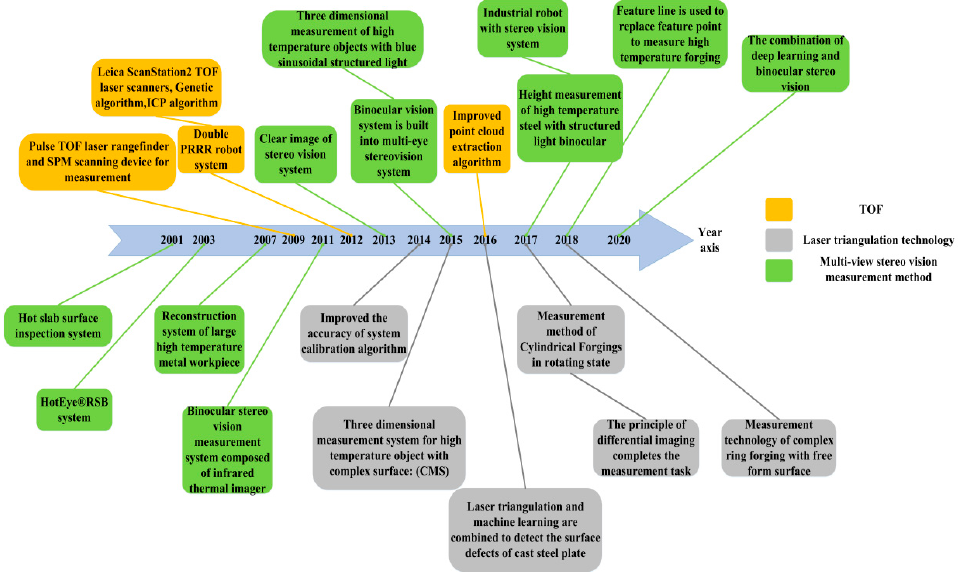
Figure 1. Timeline of technological development.